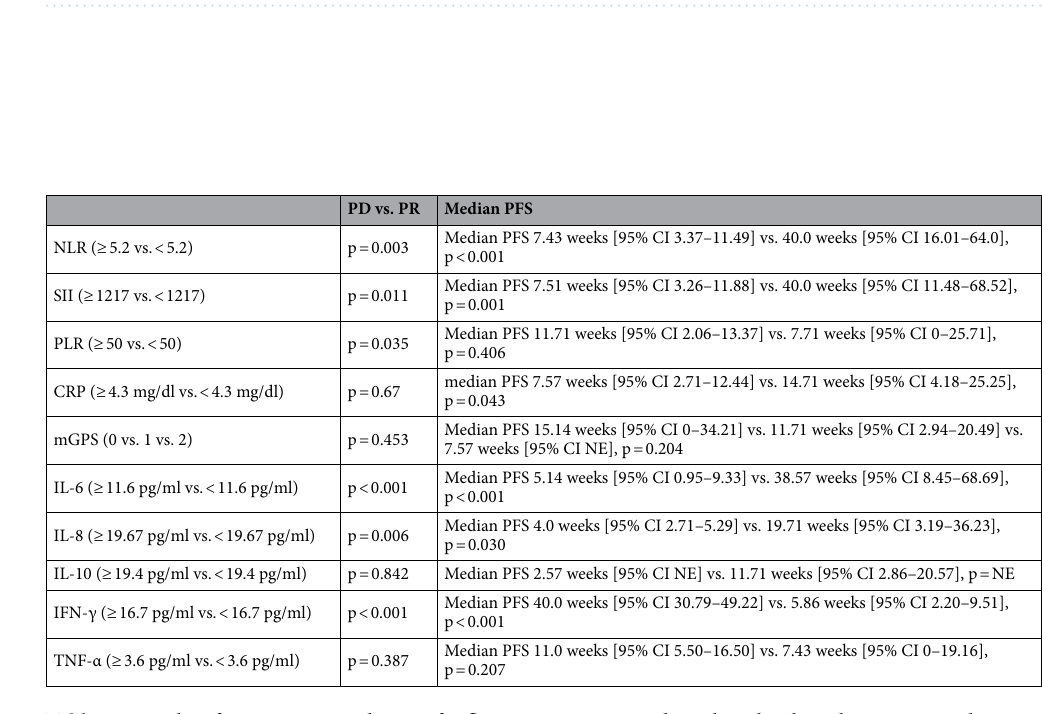
Table 3. Results of univariate correlation of inflammation scores and cytokine levels with response and PFS under ICI treatment.